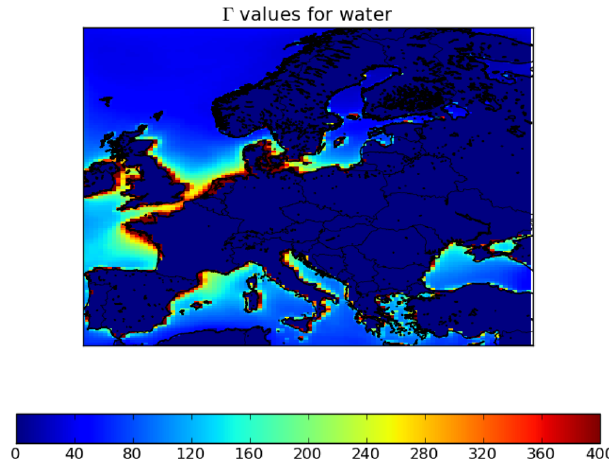
Figure 2. Molar ratios between the NH 4+ and H + concentration, i.e., Γ values, in sea water as used in the LOTOS-EUROS model for the European domain. The grid resolution in this domain is 0.50° longitude x 0.25° latitude (~28x28 km 2 ).